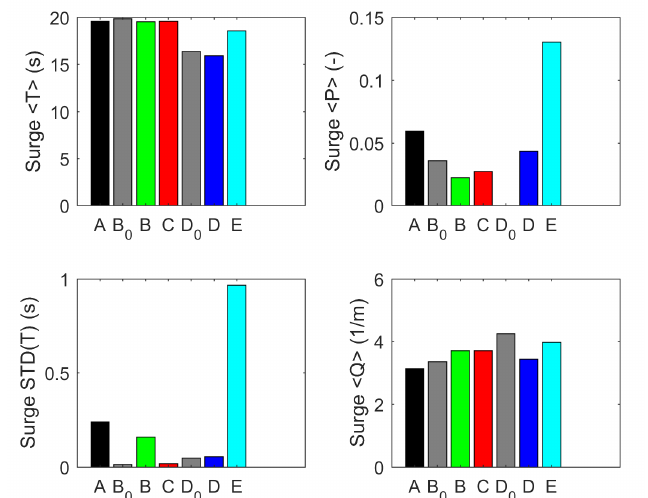
Figure 6. Surge natural periods ( left ), linear and quadratic damping estimates ( right ).